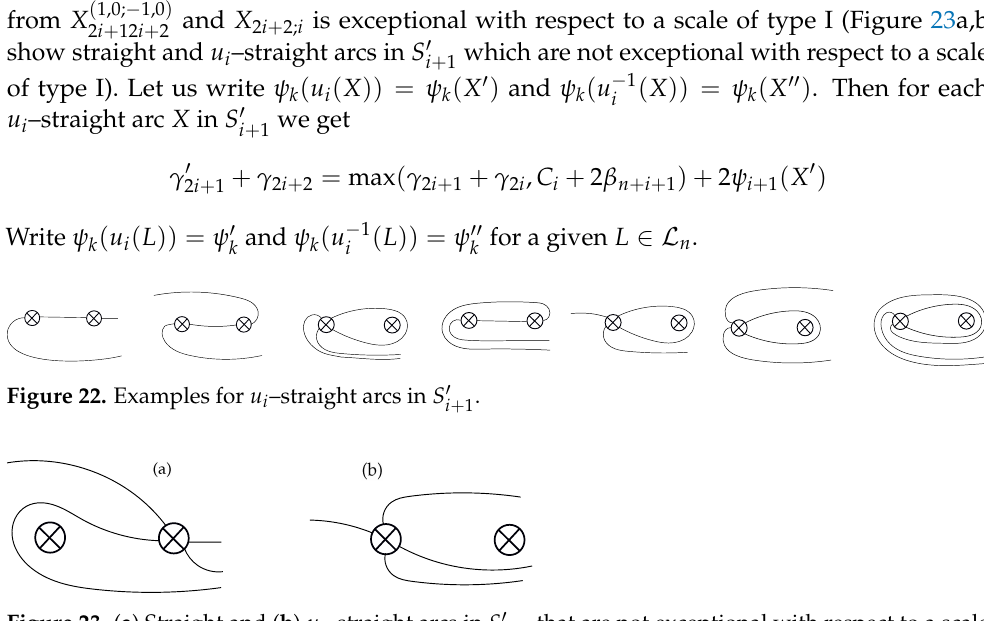
that are not exceptional with respect to a scale i + 1